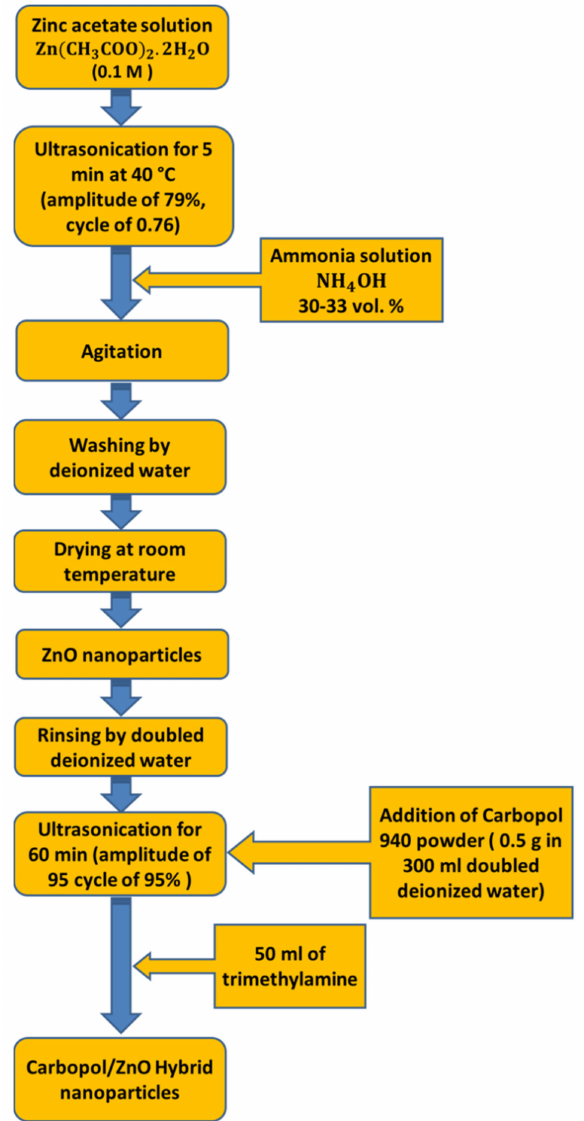
Figure 1. Schematic flowchart for the synthesis of ZnO NPs and Carbopol/ZnO hybrid nanoparti- cles